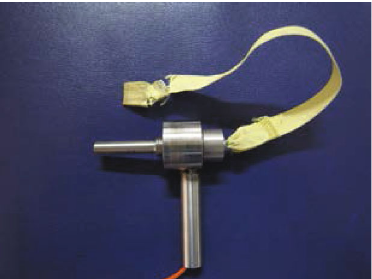
Figure 31: Ribbon